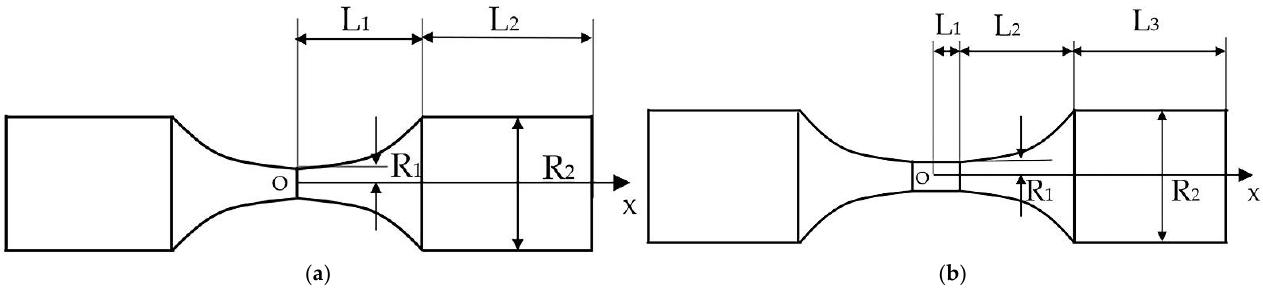
Figure 3. The variable-section sample: ( a ) The hourglass-shaped sample; ( b ) the dog-bone-shaped sample.